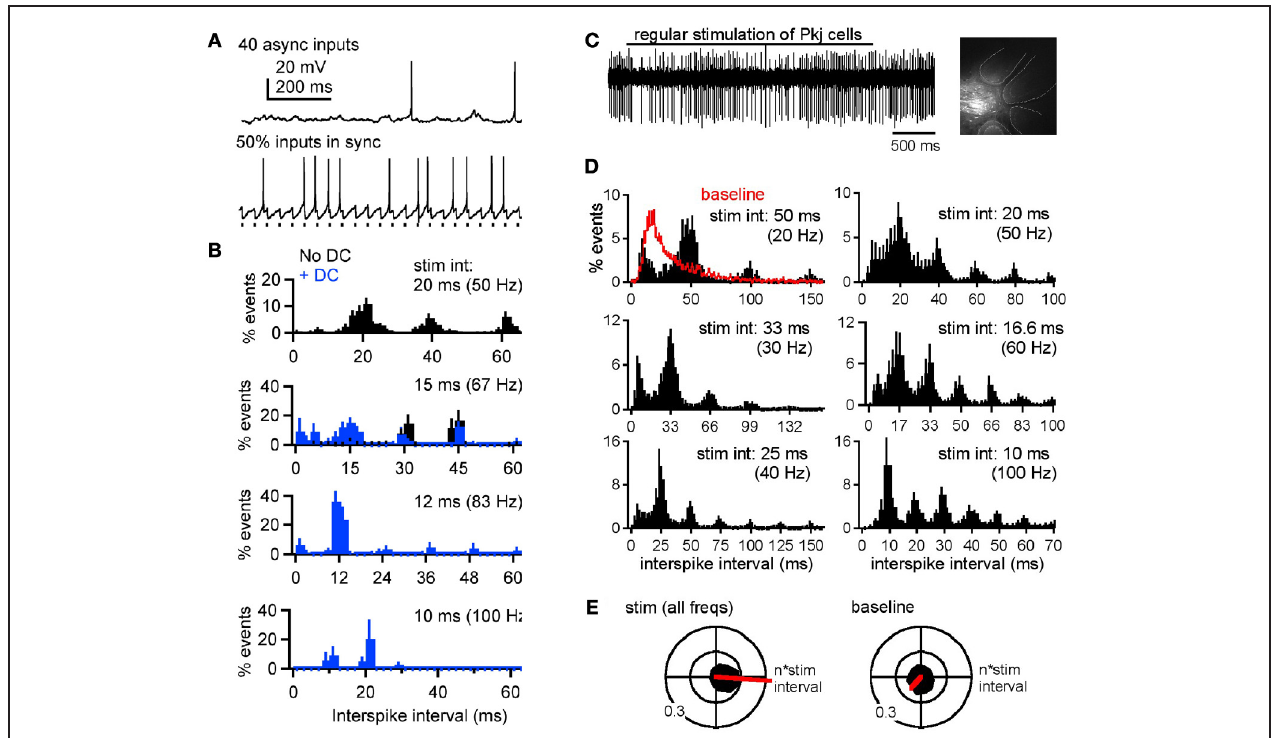
FIGURE 5 | Synchronous Purkinje inputs set spike timing of nuclear neurons, in vitro and in vivo . (A) Responses of a whole-cell current-clamped cerebellar nuclear neuron in a mouse cerebellar slice to dynamically clamped (dyn) IPSPs mimicking 40 asynchronous (top) or 20 asynchronous and 20 synchronous Purkinje inputs (bottom). (B) Normalized interspike interval distributions during partially synchronized (50%, i.e., 20 out of 40) dynIPSPs, where the rates of the synchronous input ranged from 50 to 100Hz. Abscissa tick marks indicate multiples of the interstimulus intervals of the synchronous subpopulation. Bin width, 2ms. Black: no current injection. Blue: with 200 pA steady current (DC) applied to increase spike probability during inhibition. (C) Responses of an extracellularly recorded